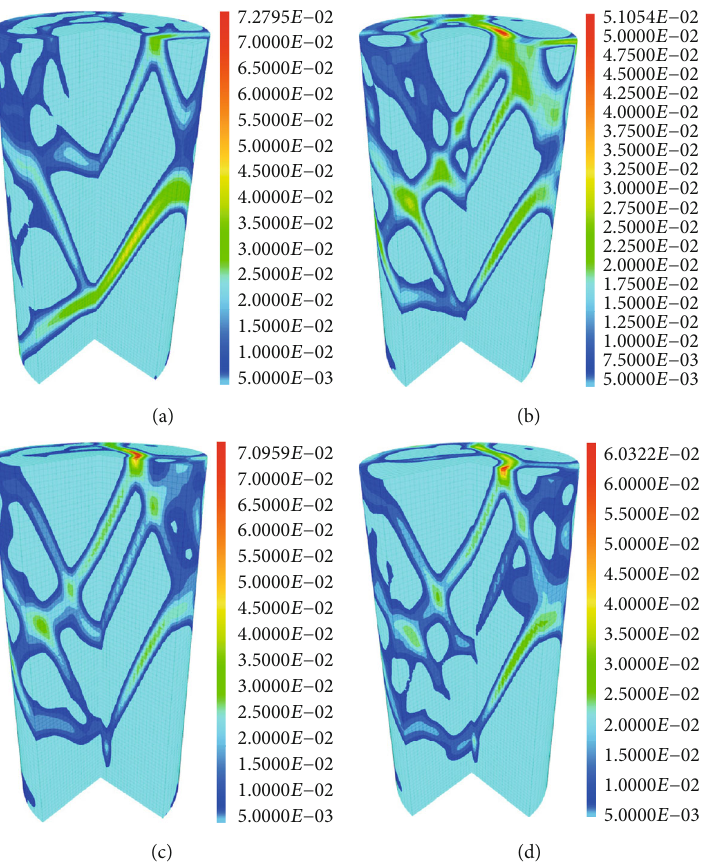
> 0 : 5 % ) at stage e under di ff erent fl uid pressures: (a) pore pressure of 2MPa, (b) pore pressure of 4MPa, (c) Figure 16: Volumetric strain ( ε v pore pressure of 6MPa, and (d) pore pressure of × 10 − 18 m 2 . The two models are used to simulate steady fl ow with di ff erent linear coe ffi cients, and the results are shown in Figure 9. According to the fl ow rate, K 1 = 80 and K 2 = 1700 fi t the lab results.